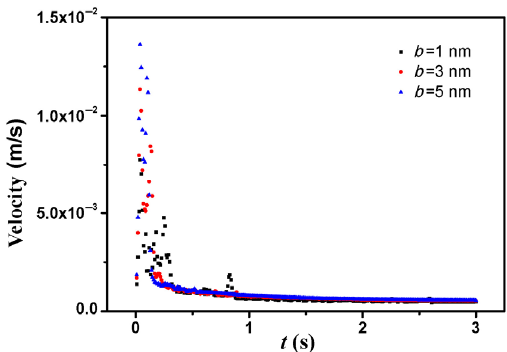
Fig. 2 Effect of slip length on silicone-oil migration velocity.